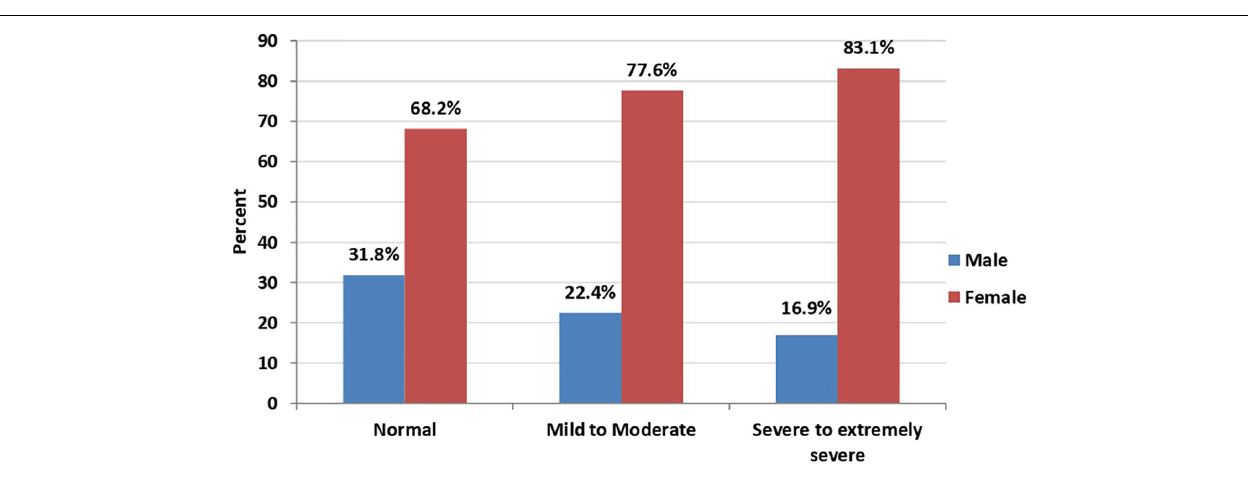
FIGURE 4 | Sex distribution among stress severity ( P -value < 0.001; N =